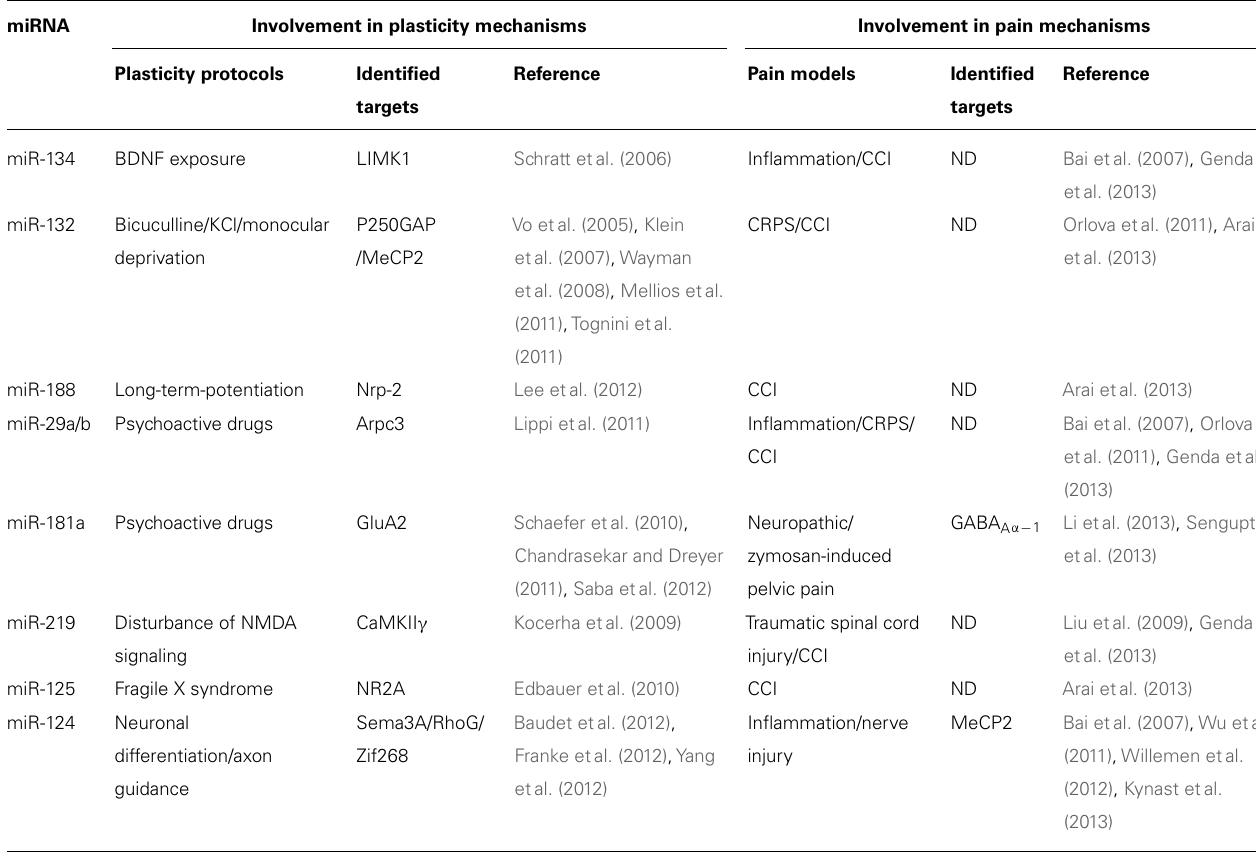
Table 1 | MicroRNAs involved in plasticity and pain mechanisms.